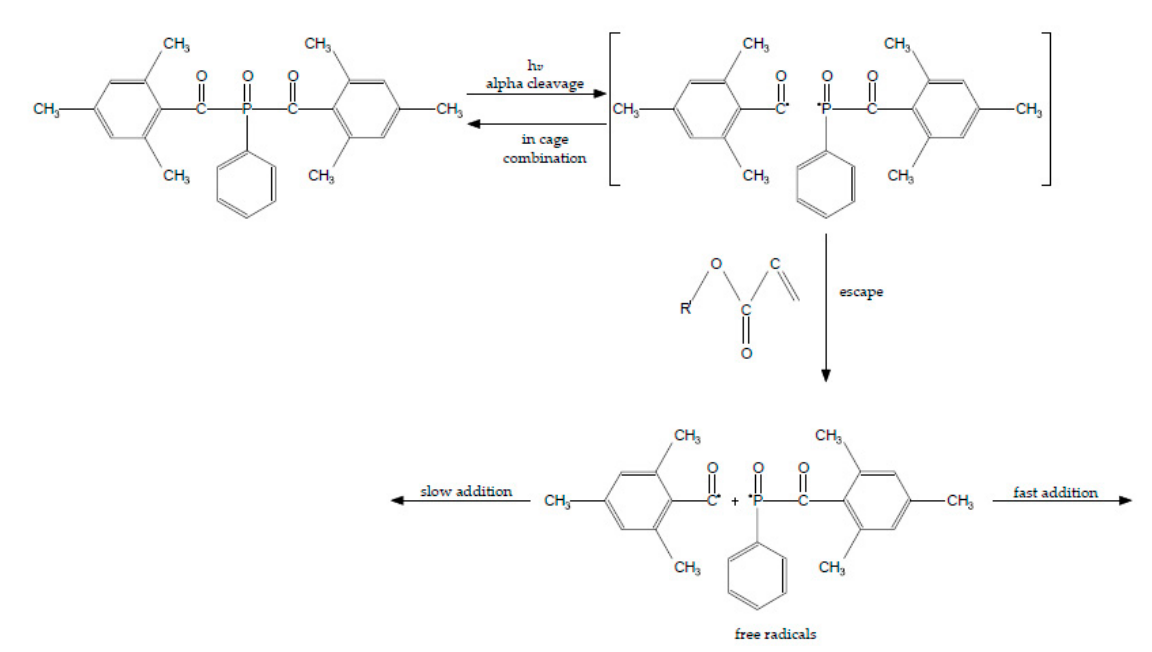
Figure 3. Alpha-cleavage of BAPO from triplet-excited state to yield radicals.